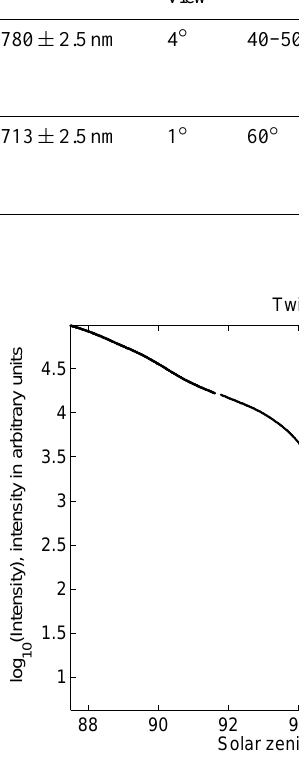
Fig. 4. An example of the measured twilight sky light intensity as a function of SZA. The curve is composed of three ensembles of consecutive measurements that differ in the exposure time. The gaps between the ensembles correspond to the interruptions needed to change the exposure